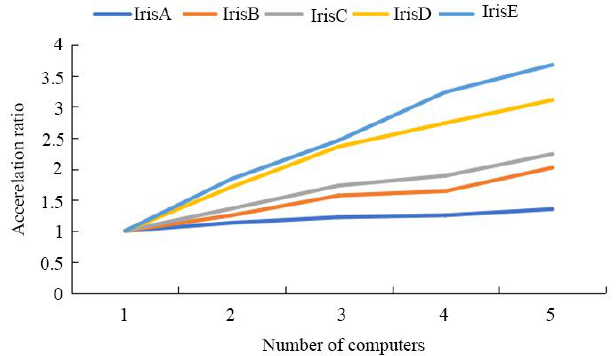
Figure 5: The acceleration ratio of the